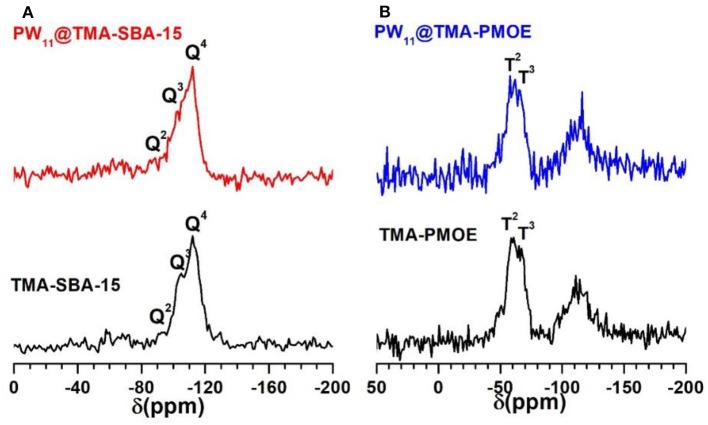
29Si MAS NMR of (A) TMA-SBA-15 and (B) TMA-PMOE composites with PW11.